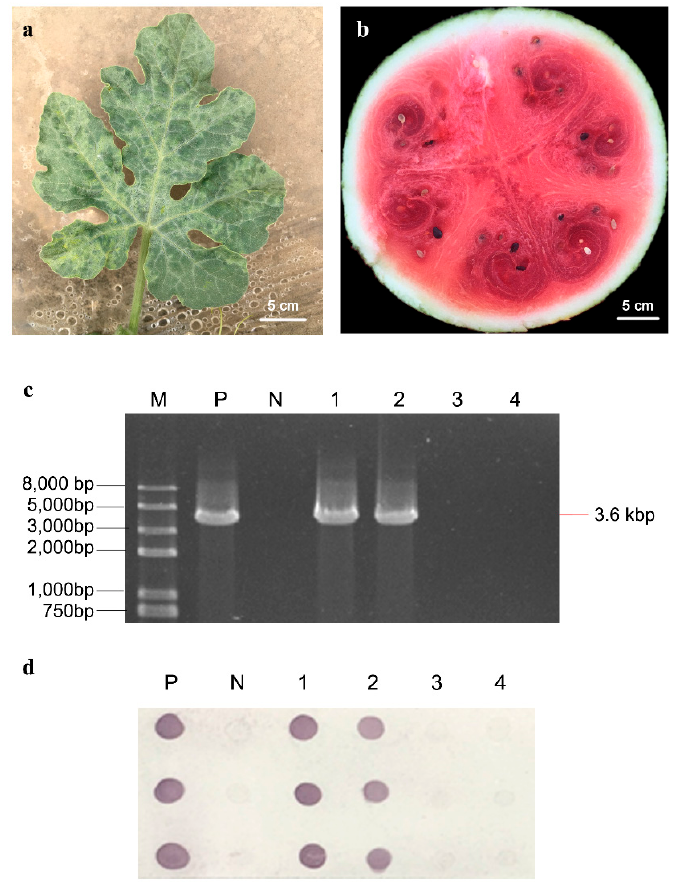
Figure 1. Symptoms and viral detection of Cucumber green mottle mosaic virus (CGMMV)-inoculated watermelon plants. ( a ) Symptom of CGMMV-inoculated watermelon leaf, ( b ) symptom of CGMMV-